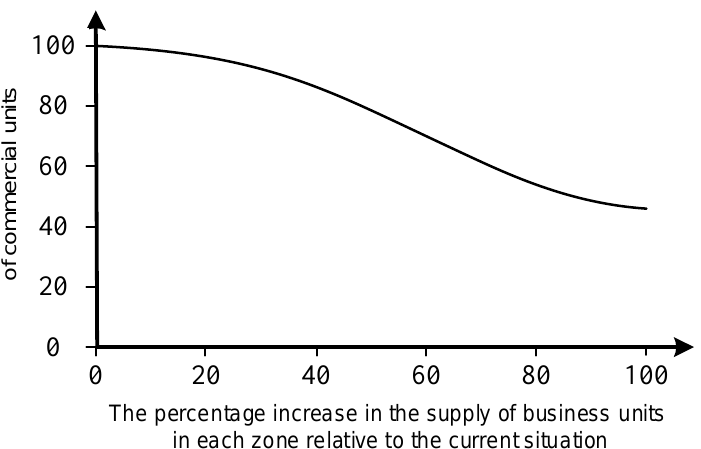
Figure 4. Change in the annual revenue of commercial units versus supply